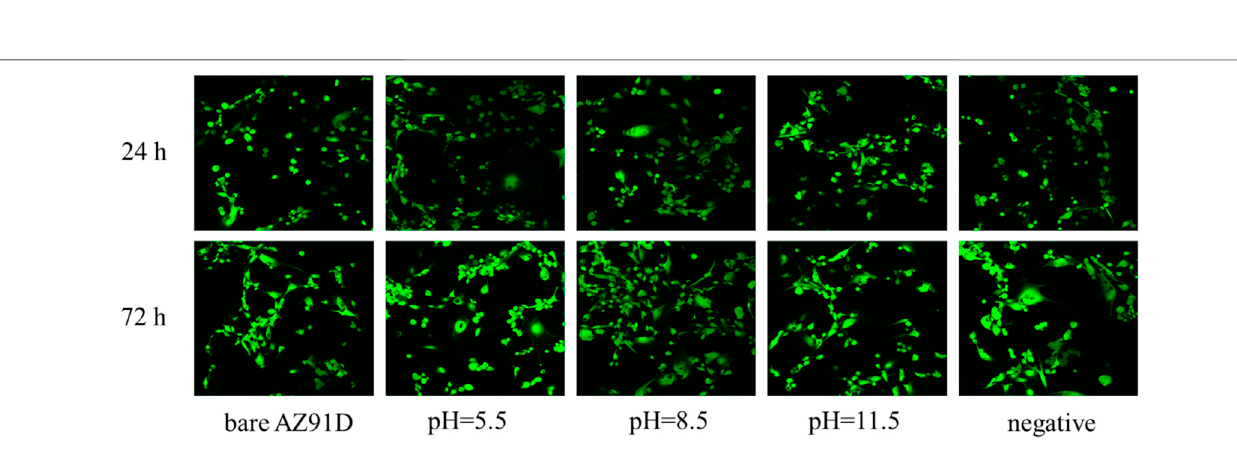
Frontiers in Chemistry |